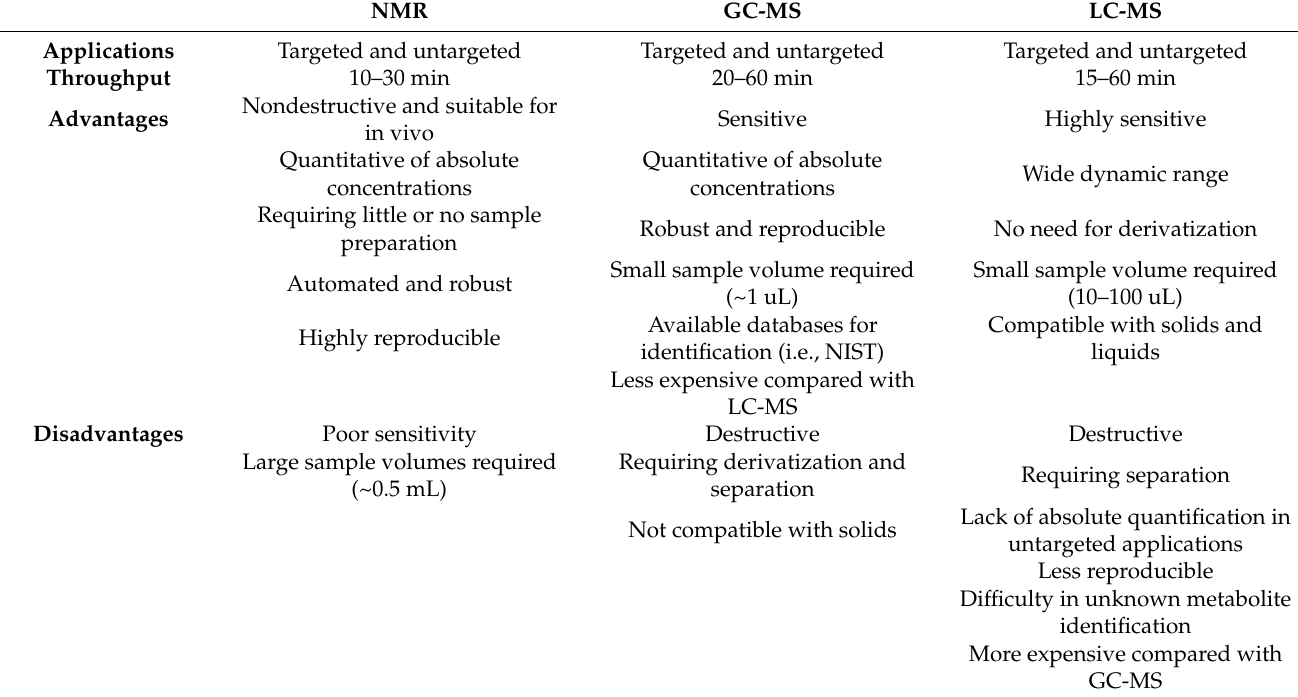
Table 1. Advantages and disadvantages of different platforms for metabolomics